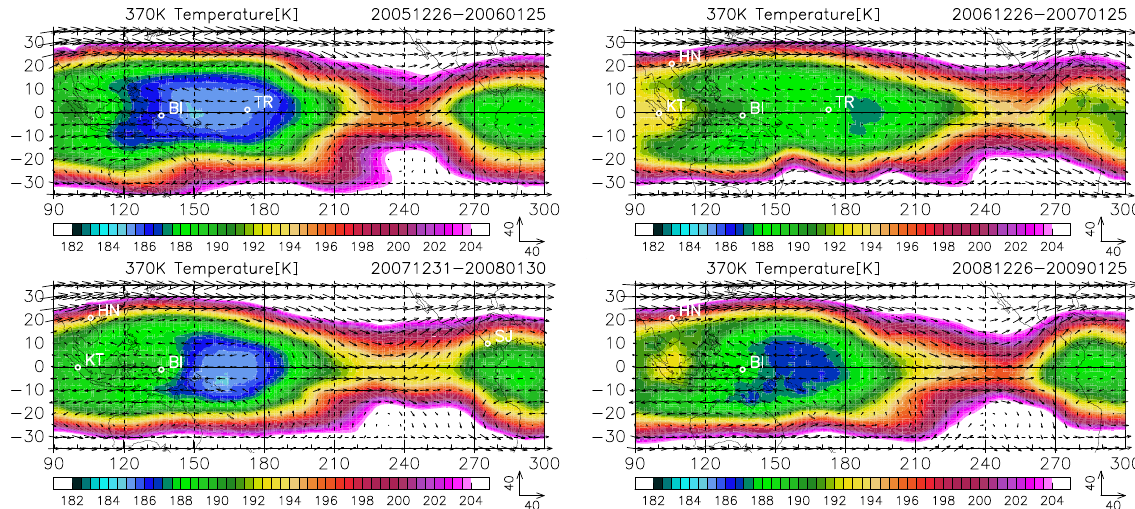
Fig. 1. Latitude-longitude sections of the mean horizontal wind component (vectors; scales of 40 m s − 1 at the bottom right) and temperature (colour) on 370 K isentropic surface during four SOWER campaigns deduced from ECMWF operational analyses. The averages are taken for 31 days covering the primary campaign period. Ground stations operated during the corresponding period, Tarawa (TR), Biak (BI), Kototabang (KT), and Hanoi (HN), are indicated.